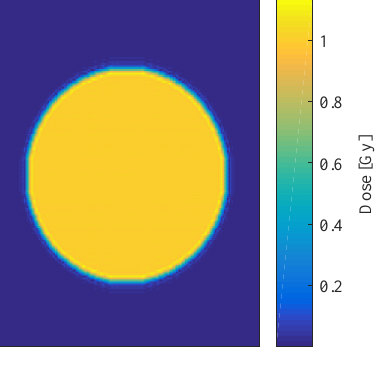
Figure 8. Reconstruction of the dose map for the phantom with embedded 1 Gy absorbed-dose